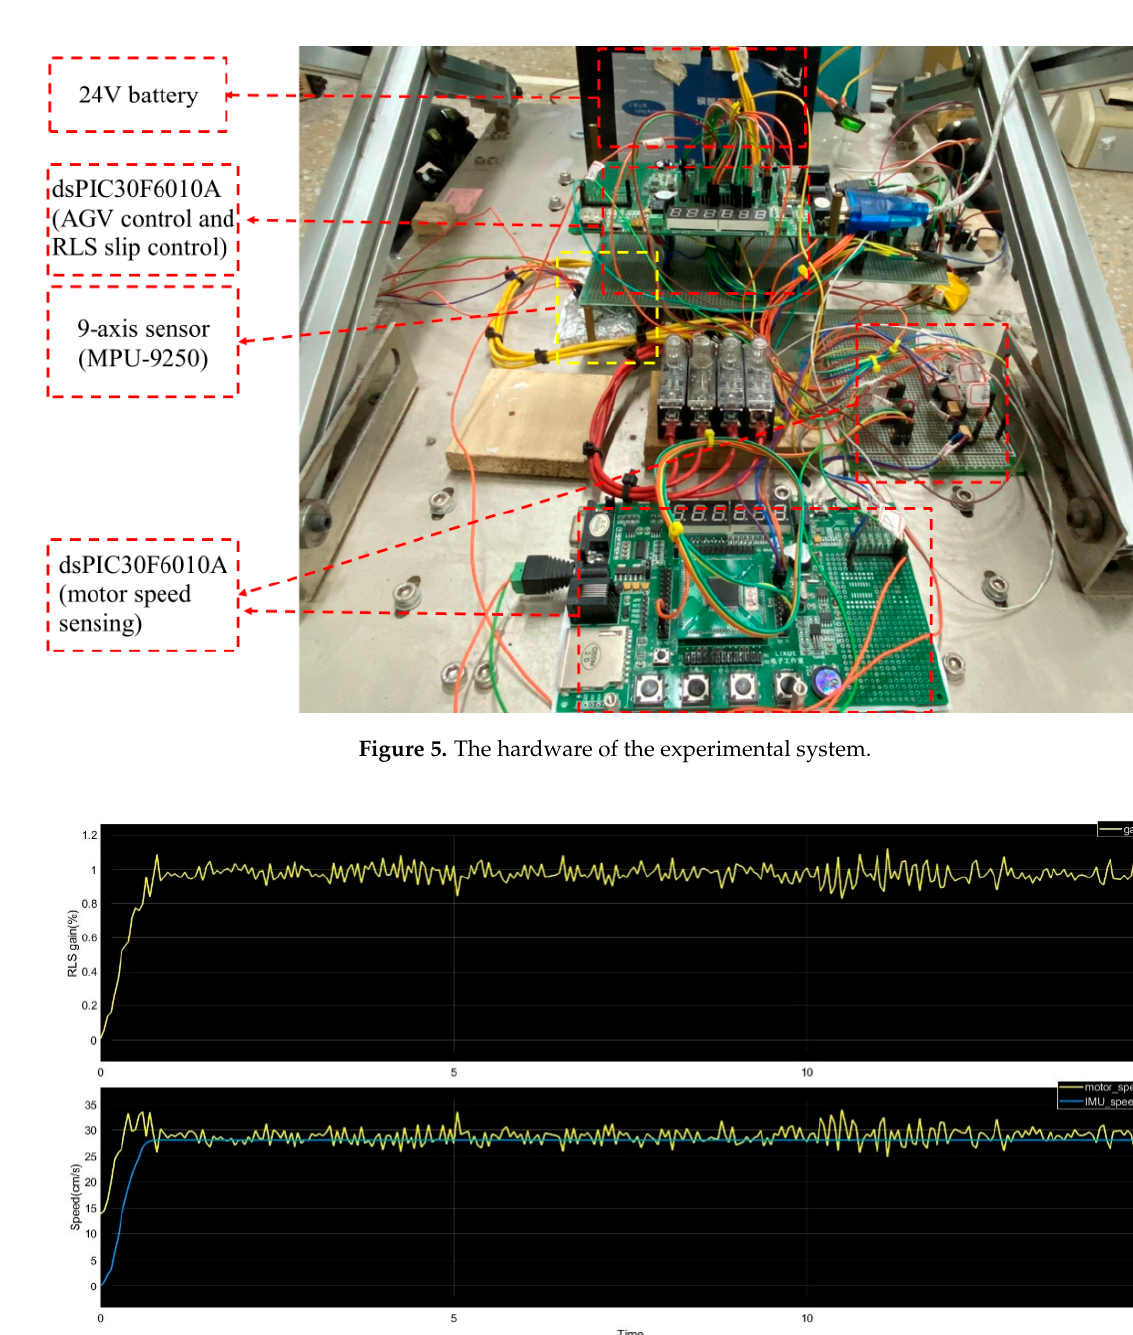
Figure 6. Estimated value by RLS method, motor speeds, and the vehicle speed of the first motor.